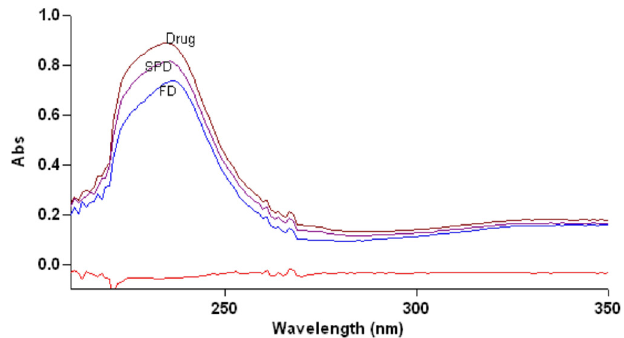
FIGURE 3 - Effect of β -CD concentration on UV absorption of